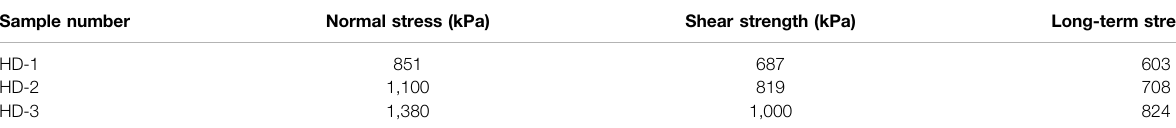
TABLE 2 | Long-term strength of samples under different normal stresses.